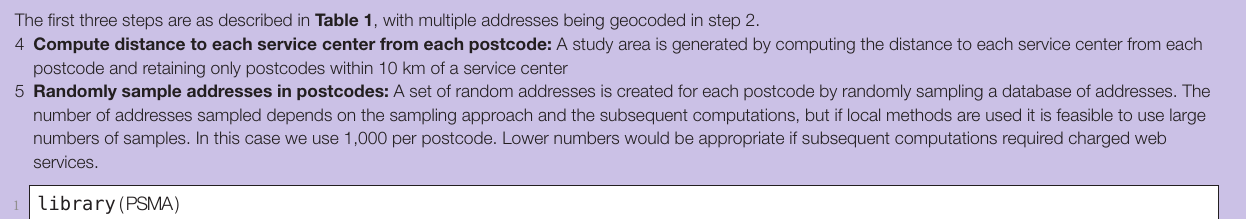
TABLE 3 | Steps in computation of catchment basin and case load for rehabilitation centers. The first three steps are as described in Table 1 , with multiple addresses being geocoded in step 2. 4 Compute distance to each service center from each postcode: A study area is generated by computing the distance to each service center from each postcode and retaining only postcodes within 10 km of a service center 5 Randomly sample addresses in postcodes: A set of random addresses is created for each postcode by randomly sampling a database of addresses. The number of addresses sampled depends on the sampling approach and the subsequent computations, but if local methods are used it is feasible to use large numbers of samples. In this case we use 1,000 per postcode. Lower numbers would be appropriate if subsequent computations required charged web